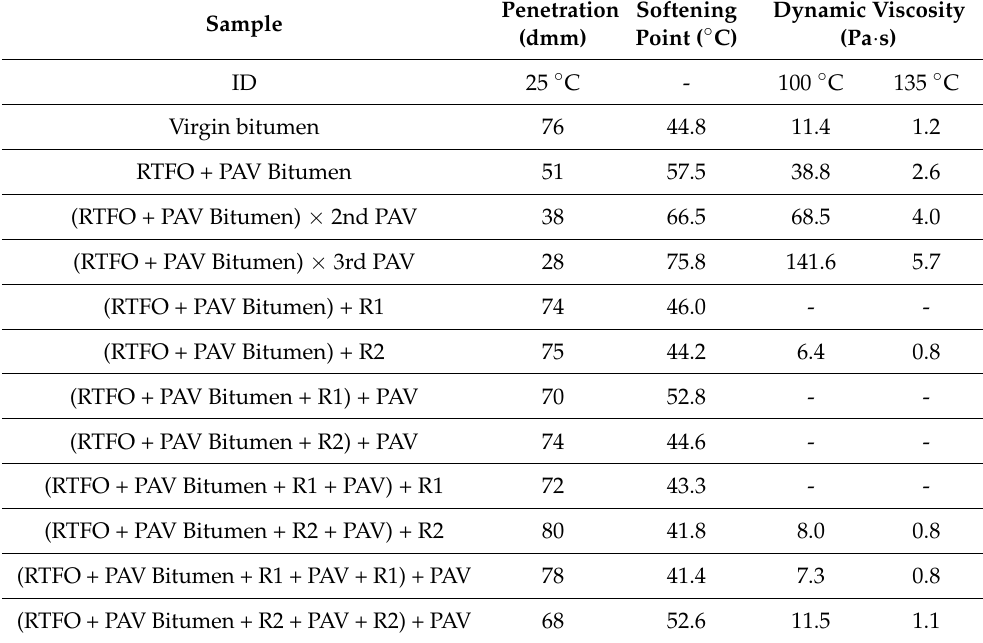
Table 4. The physical/rheological properties of test bitumen with and without the recycling